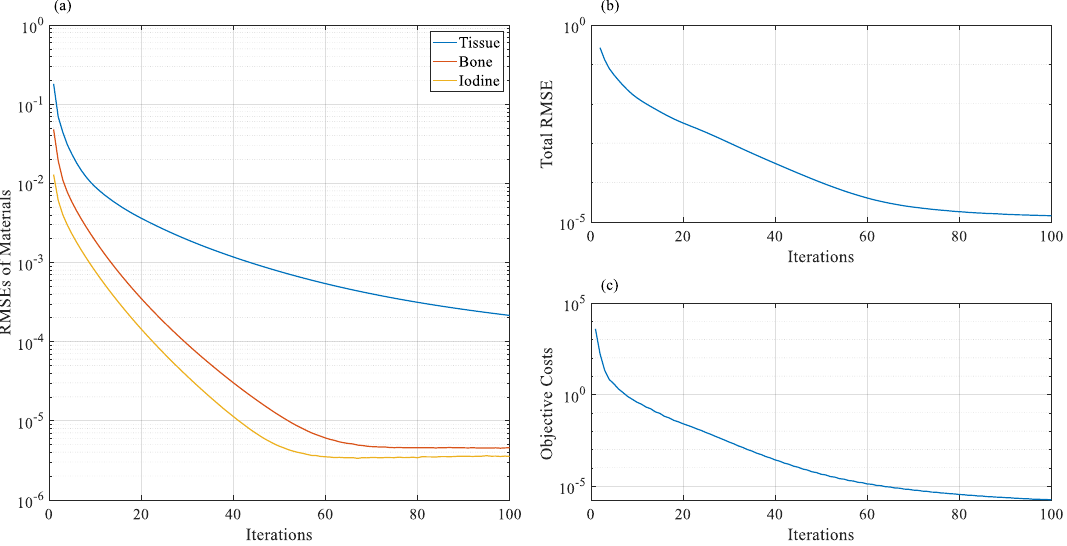
Figure 3. Convergence behaviors of the proposed method, where ( a ) indicates the RMSEs of three basis materials, ( b ) indicates the total RMSE of the proposed IPAD method, and ( c ) represents the costs of the objective function.